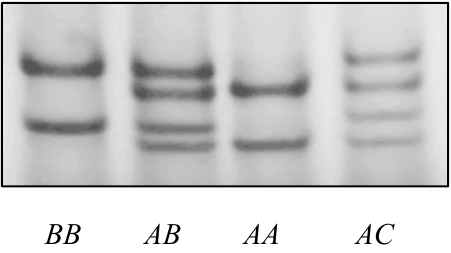
Figure 2. Representative PCR-SSCP patterns for the caprine KAP20-2 gene. Four genotypes are shown, and there are three unique banding patterns, which correspond to three alleles A–C .